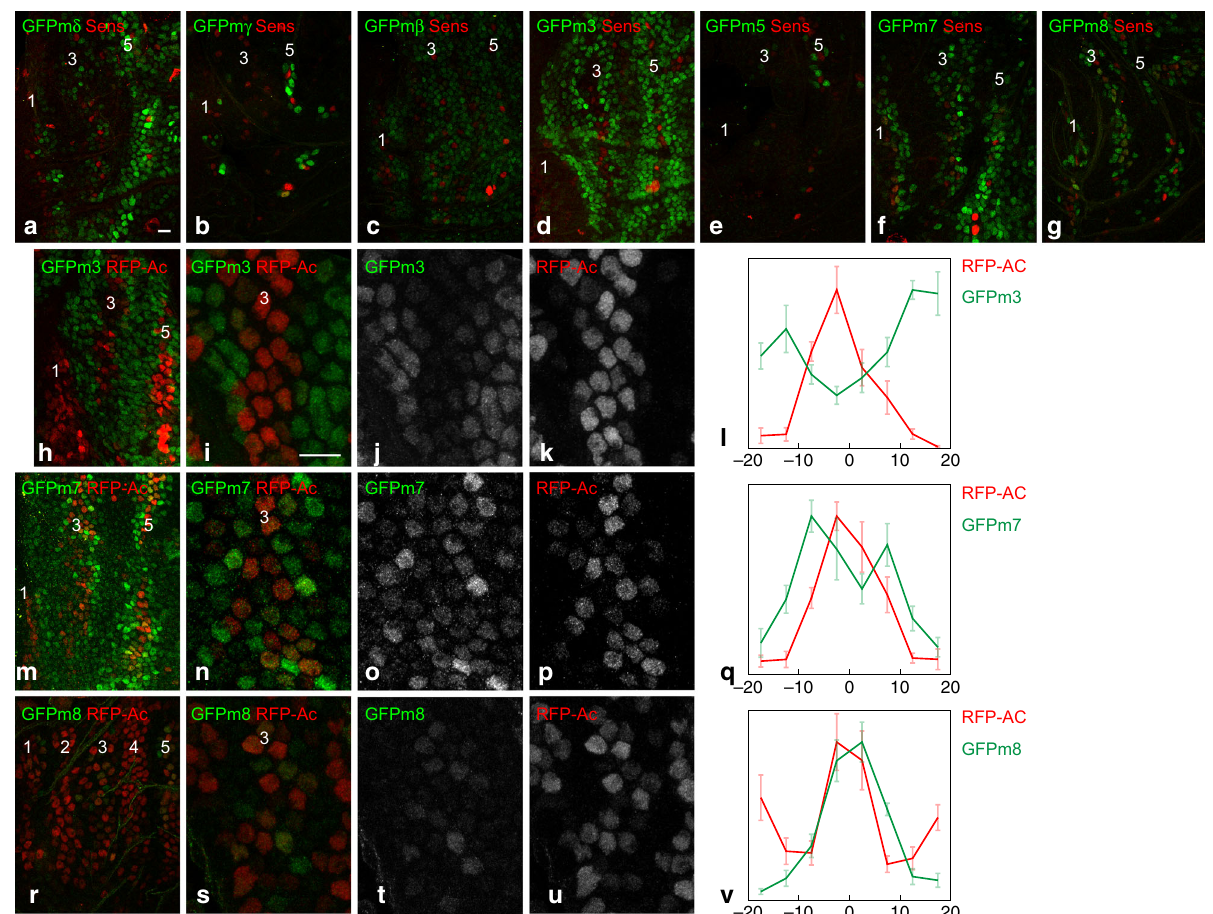
Fig. 6 Early-onset and late-onset E(spl)-HLH factors exhibit distinct accumulation patterns. a – g Expression of GFP-tagged E(spl)-HLH factors (GFP, green) at 8 h apf. The early-onset factors m β ( c ) and m3 ( d ) appeared to accumulate on the sides of the proneural stripes (Sens, red), whereas the late-onset factors m δ ( a ), m7 ( f ), m8 ( g ) and, to a lesser extent m γ ( b ) and m5 ( e ), appeared to be intermingled with the Sens-positive proneural stripe cells. h – l GFPm3 (green) accumulated in cells with very low Ac levels (red), fl anking the proneural stripe 3, as shown in the high magni fi cation views of stripe 3 at ~7.5 h apf in i – k , and the corresponding quanti fi cation of the GFP and RFP nuclear signals in l ( n = 5; the mean + / − standard error of normalized intensities is plotted as a function of the distance, in μ m, relative to the center of the stripe). m – v GFPm7 (green; m – q ; ~7.5 h apf) and GFPm8 (green; r – v ; ~8 h apf) accumulated in proneural stripe 3 cells with low/intermediate levels of Ac (red), but not in presumptive SOPs that have high levels of Ac. Note that fewer cells express GFPm8 at the onset of proneural stripe 3, suggesting that GFPm7 may be expressed slightly earlier than GFPm8. High magni fi cation views ( m – p and s – u ) and quanti fi cations ( q , n = 7; v , n = 9) as in panels i - l . Scale bars are 10 μ m ( a : a – h , m , r ; i : i – k , n – p , s – u